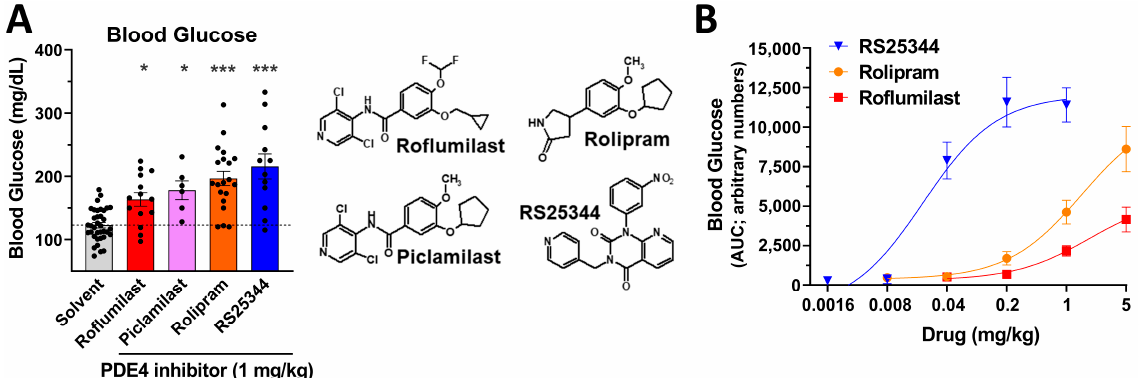
Figure 2. An acute increase in blood glucose levels is a class effect of PAN-PDE4 inhibitors. ( A ) Blood glucose levels in postprandial mice are shown at 30 min after the injection (i.p.) of the PAN-PDE4 inhibitors roflumilast, piclamilast/RP73401, rolipram, and RS25344 (all 1 mg/kg), or solvent controls. The chemical structures of the PDE4 inhibitors are shown for comparison. Data represent the mean ± SEM. Statistical significance was determined using Kruskal–Wallis and Dunn’s post hoc tests and is indicated as * ( p < 0.05) and *** ( p < 0.001). ( B ) After measuring baseline blood glucose levels (0 min time point) in postprandial mice, the animals were injected with the indicated doses of RS25344, rolipram, or roflumilast (all i.p.; n ≥ 6) and blood glucose levels were measured again at 30, 60, 90, and 120 min after drug injection. Data represent the mean ± SEM and are expressed as the area under the curve (AUC). Dose-response curves for RS25344, rolipram, and roflumilast are significantly different ( p < 0.01) from each other, as determined by a two-way ANOVA with Sidak’s post hoc